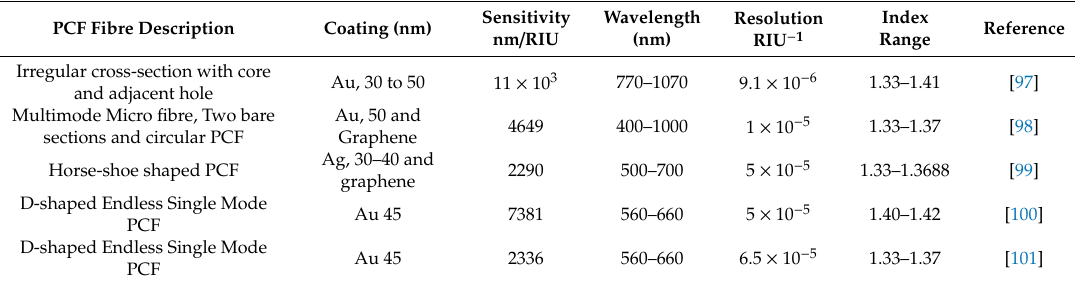
Table 6. Summary of photonic crystal fibre plasmonic sensors.